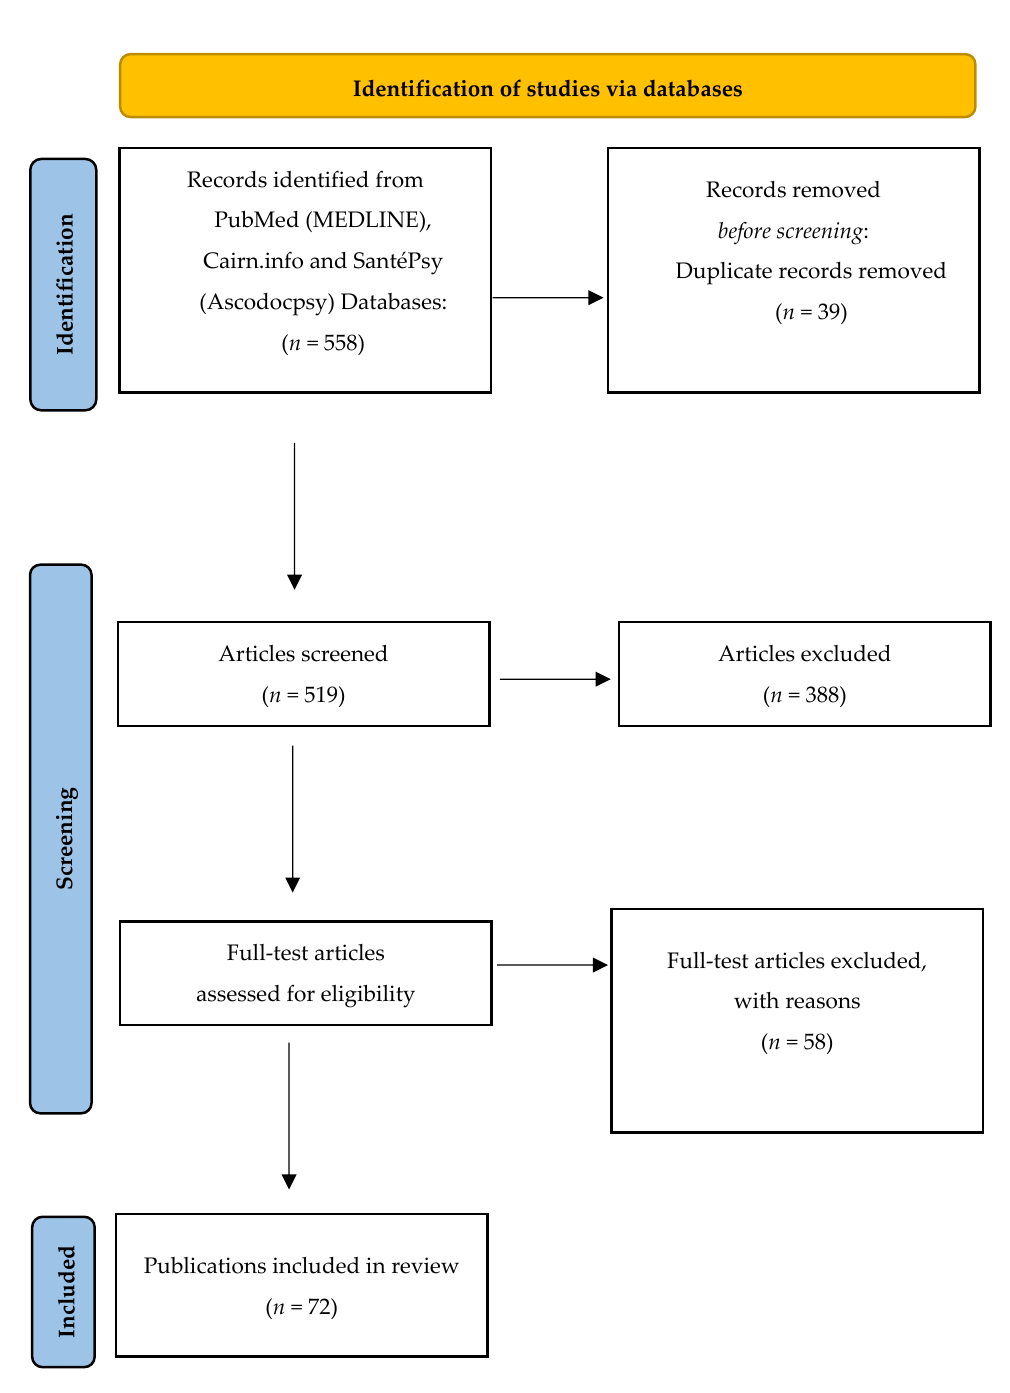
Figure 1. Flow chart.